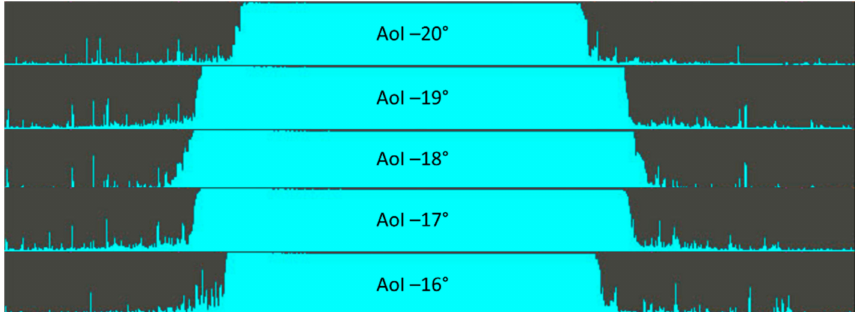
Figure 13. Raw intensity data for orange plexiglass. The other transparent plastics have simi- lar intensity.